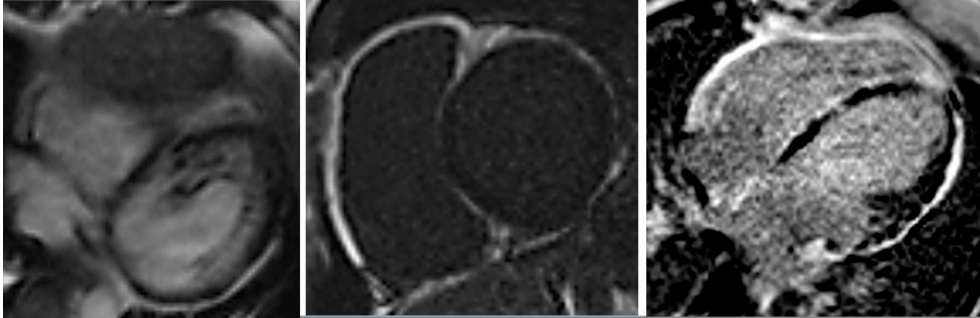
Figure 3. Cardiac MRI: left ventricular (LV) end-diastolic diameter (EDD) 66 mm, LV end diastolic volume EDV 243 mL, EF 41%, RV EDD 48 mm, RV EDV 115 mL/m 2 , EF 25%, areas of hypo/diskinesia of the front wall of RV, in the early and late phases—subepicardial areas of late gadolinium enhancement throughout LV, in IVS from the side of RV and along the walls of